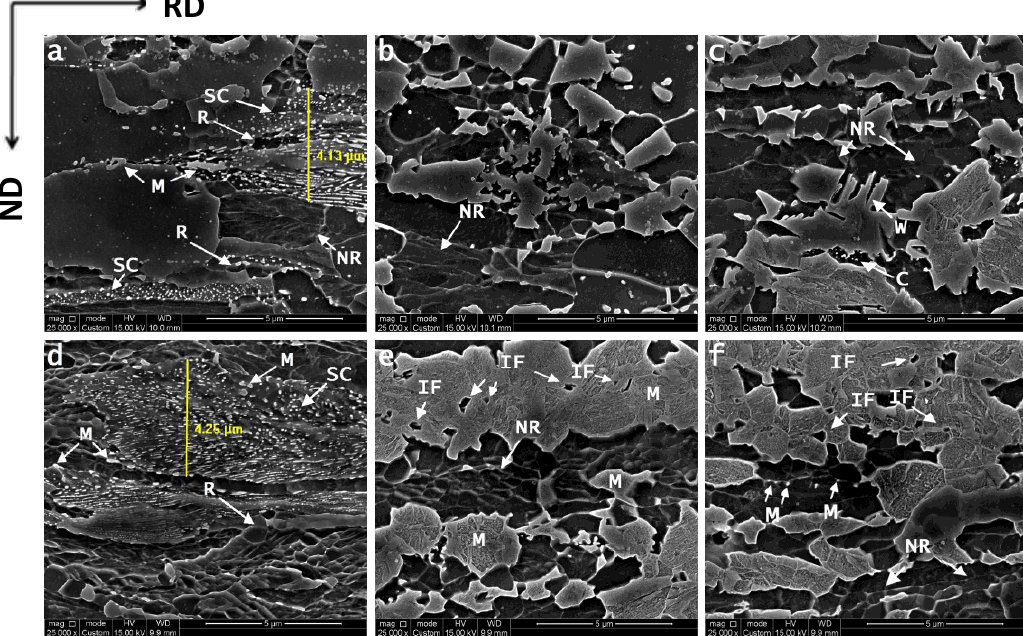
Figure 1. SEM images of samples heated at 150 °C/s to: 738 °C ( a ); 782 °C ( b ) and 838 °C ( c ); and at 1500 °C/s to: 749 °C ( d ); 842 °C ( e ) and 862 °C ( f ). Arrows point to cementite (C), martensite (M), non-recrystallized ferrite (NR), recrystallized ferrite (R), spheroidized cementite (SC), intragranular ferrite (IF) and Widmanstätten ferrite (W). Scale bar for all images is 5 µm.